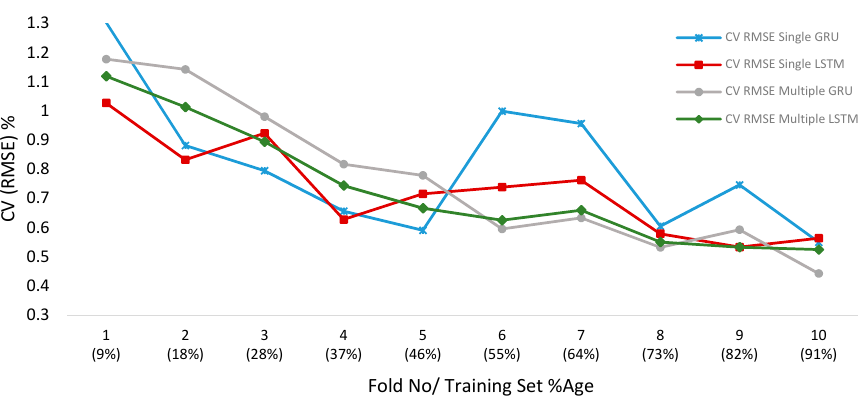
Figure 17. Time series cross validation with multiple Train-Test Splits. Figure 17 . Time series cross validation with multiple Train-Test Splits.